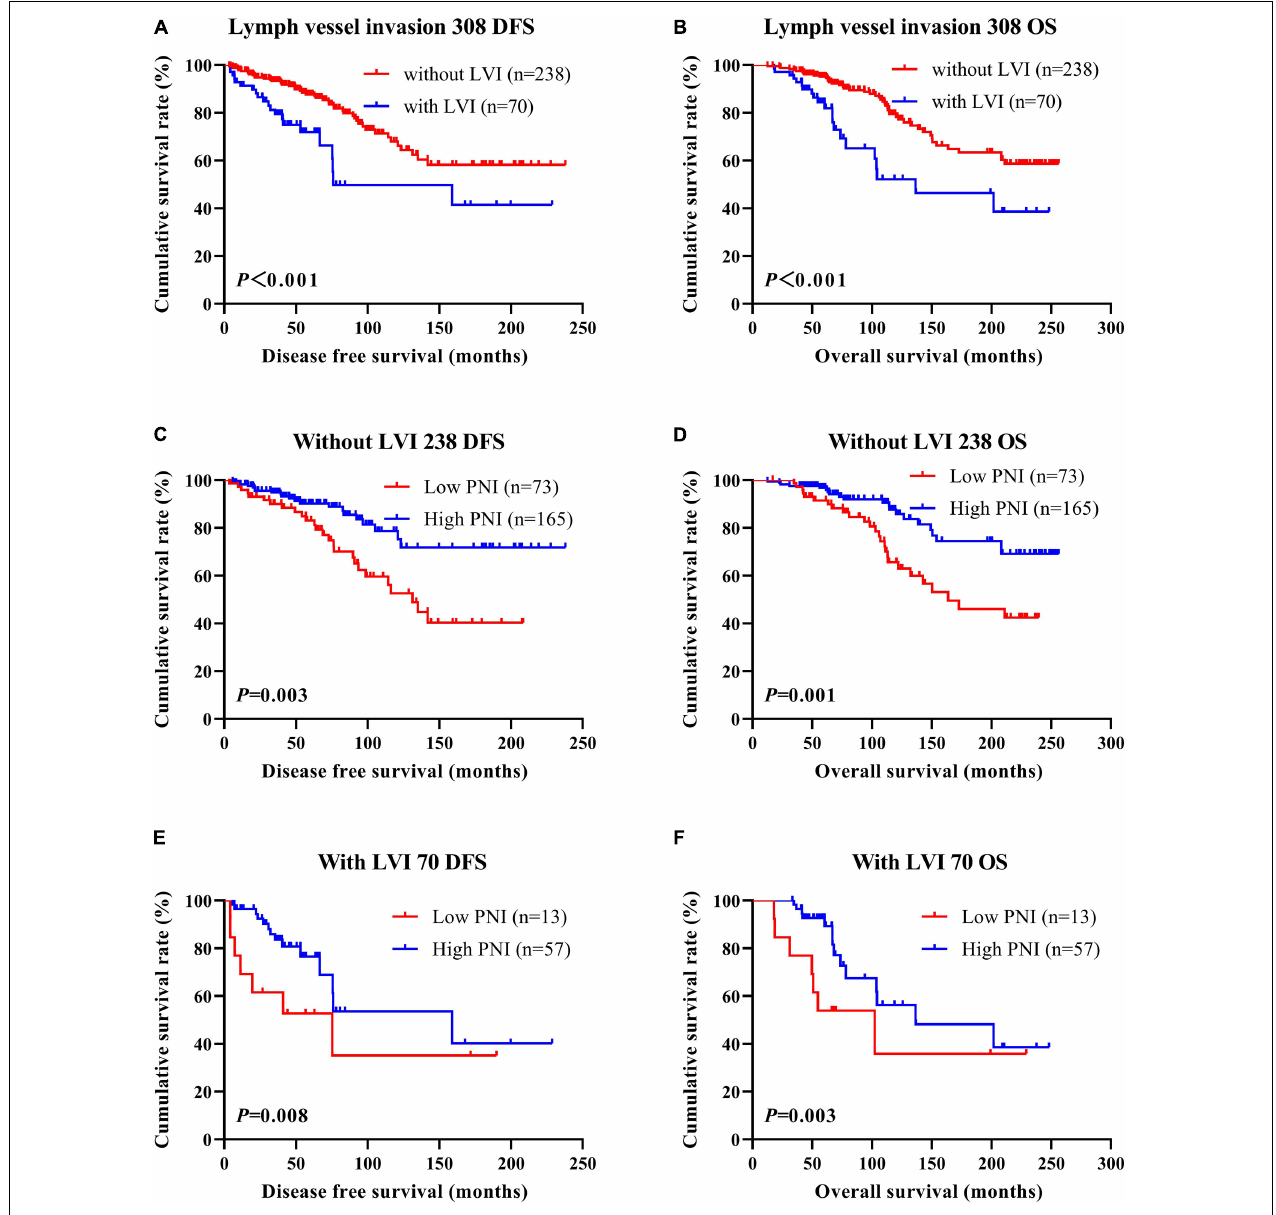
FIGURE 8 | Disease-free survival (DFS) and overall survival (OS) of patients with breast cancer by lymph vessel invasion status in the non-neoadjuvant chemotherapy (NACT) group. (A,B) Kaplan-Meier analysis of the DFS (A) and OS (B) of breast cancer patients by lymph vessel invasion status in non-NACT group. (C,D) Kaplan-Meier analysis of the DFS (C) and OS (D) of patients without lymph vessel invasion by prognostic nutritional index (PNI) in non-NACT group. (E,F) Kaplan-Meier analysis of the DFS (E) and OS (F) of patients with lymph vessel invasion by PNI in non-NACT